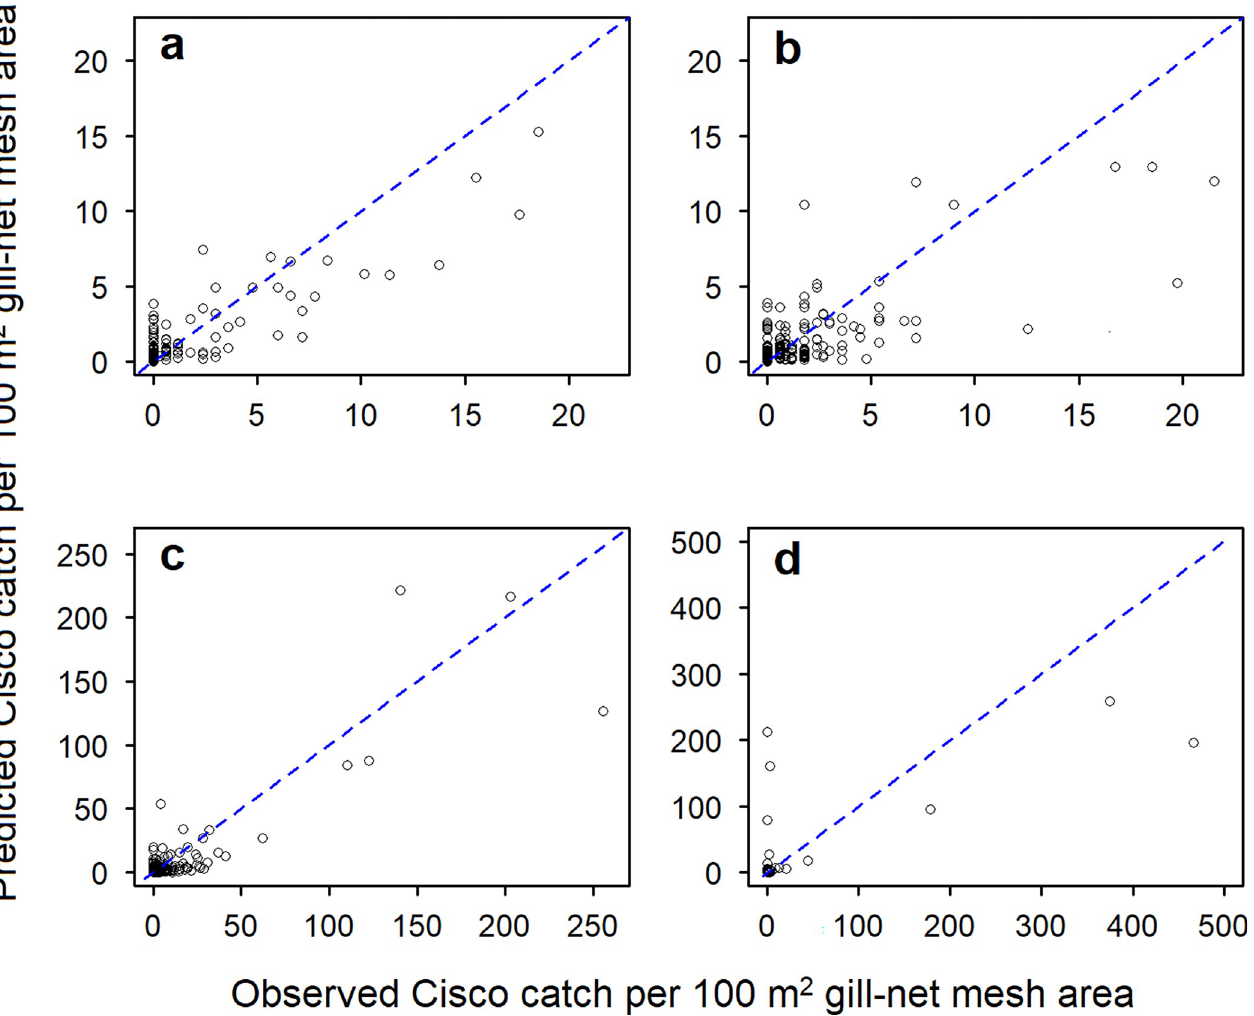
Fig 2. Observed and predicted Cisco catch per 100 m 2 gill-net mesh area for (a) Lake Superior in 1952–1953, (b) Lake Superior in 1959, (c) Lake Michigan in 1952–1962, and (d) Saginaw Bay in fall, 1956. Circles represent data points and dashed line represents a 1:1